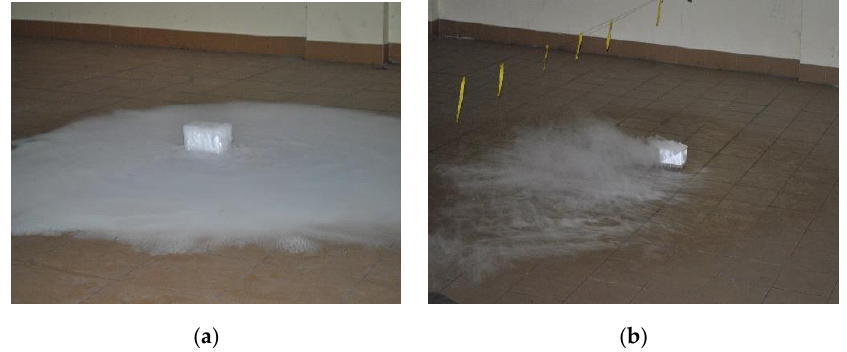
Figure 7. The dry ice test results: ( a ) jet fan ventilation system turned off; ( b ) jet fan ventilation system activated.